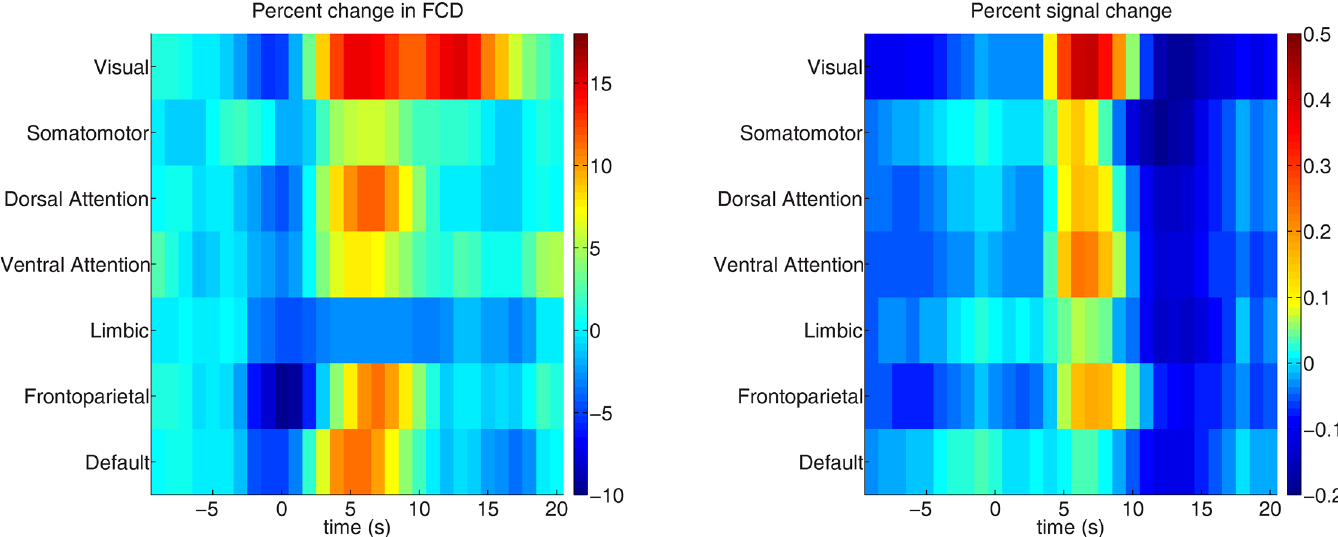
Fig 4. Mean FCD percent change and percent signal change across atlas based regions. Mean FCD percent change along with the percent signal change across time (-10 to 20 s) for functional regions as defined by the [24] atlas at window size of 13.2 s (TR = 0.66 s). The 0 s indicates the stimulus onset.